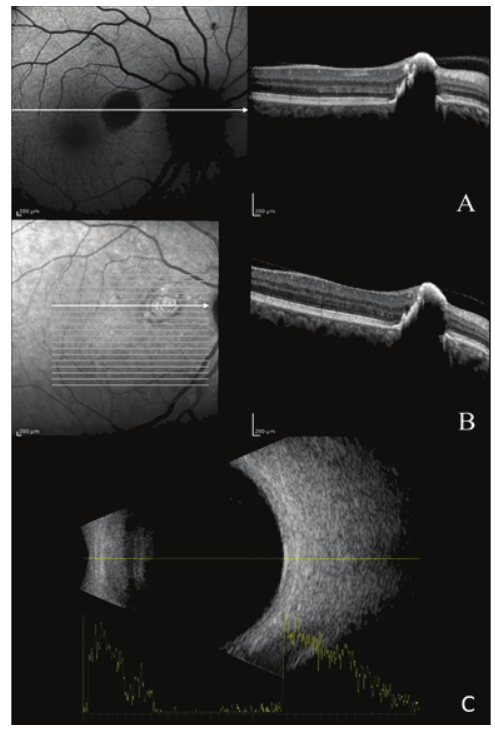
Figure 2. Optical coherence tomography (OCT) showing a retinal lesion with high surface reflectivity, deep optical shadowing, and full-thickness retinal involvement. Image (A) was taken in 2009, and image (B) in 2017. The arrows on the left side autofluorescence (AF) and infrared images show the level of B scans that although not registered pass through the same location based on fundus landmarks. The lesion shows hypoautofluorescence in AF imaging. (C) B scan ultrasonography reveals a flat lesion with high internal